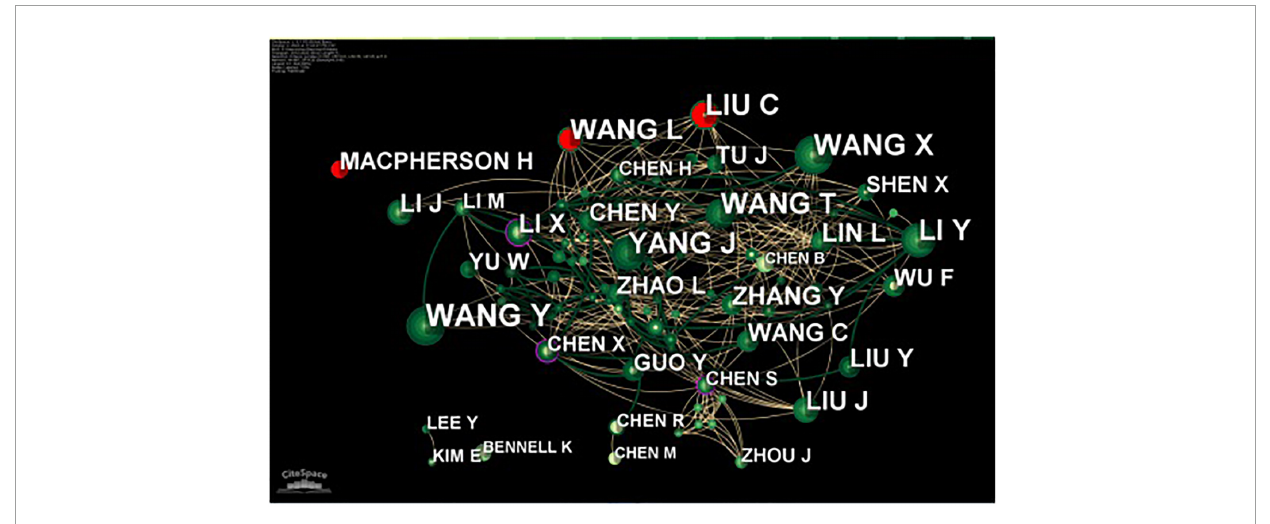
FIGURE4 The collaboration map of Authors related to traditional Chinese non-pharmacological therapies on knee osteoarthritis (KOA).